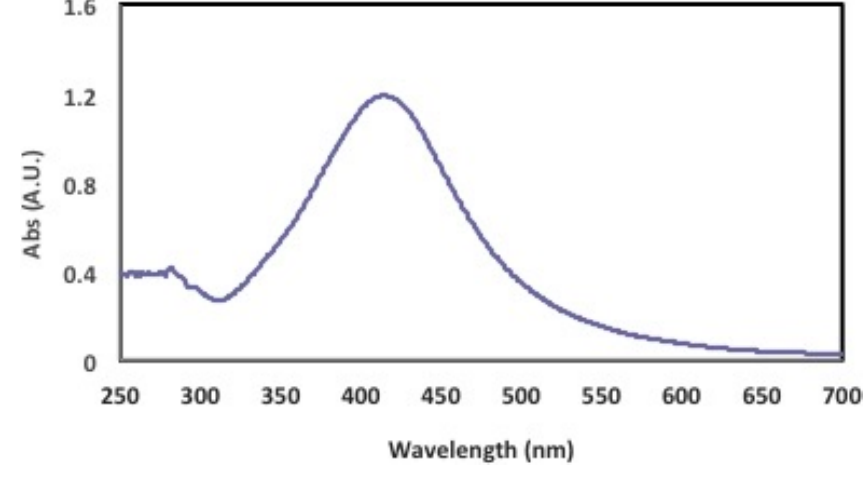
Figure 2. Spectrophotometric absorption peak at 413 nm of AgNPs synthesized by Fusarium oxysporum .